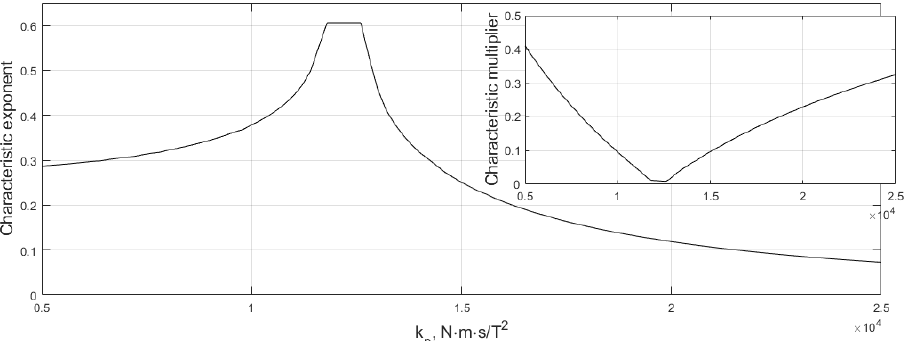
Figure 2. Stability of the o ff set angles’ origin.